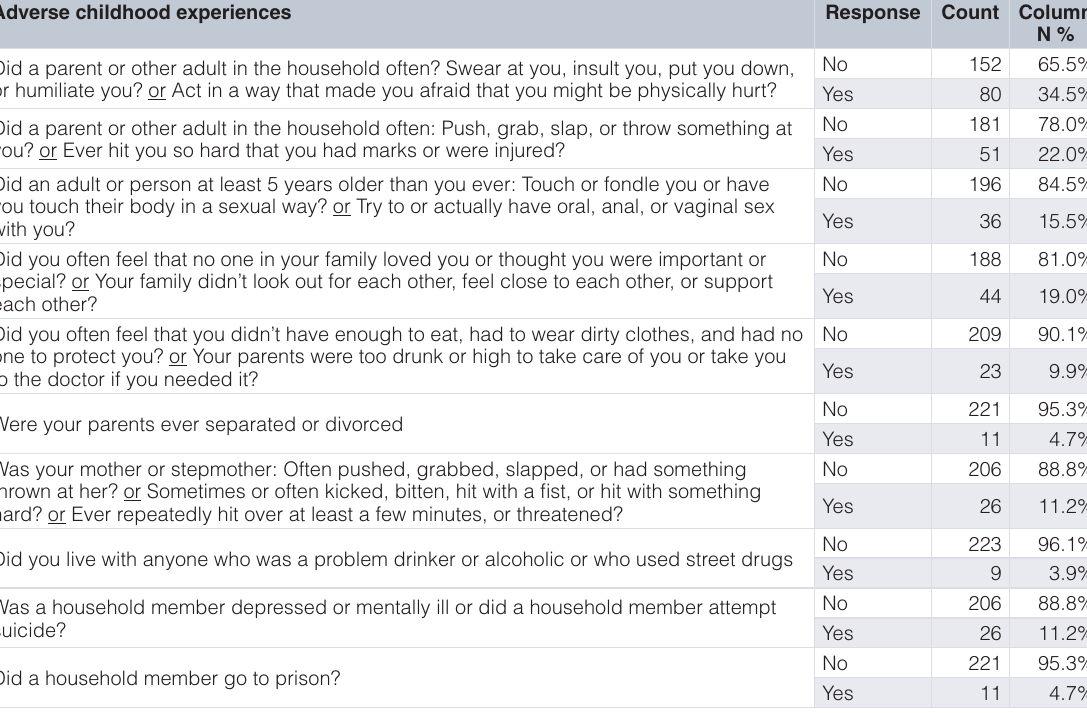
Table 2. Adverse childhood experiences reported by